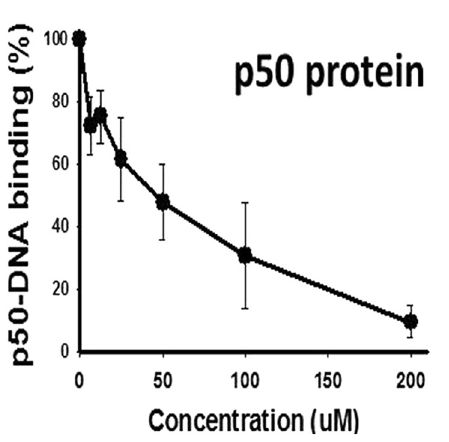
Figure 5. Inhibition of recombinant NF-κB (p50) DNA binding by 4-OXO-DHA.